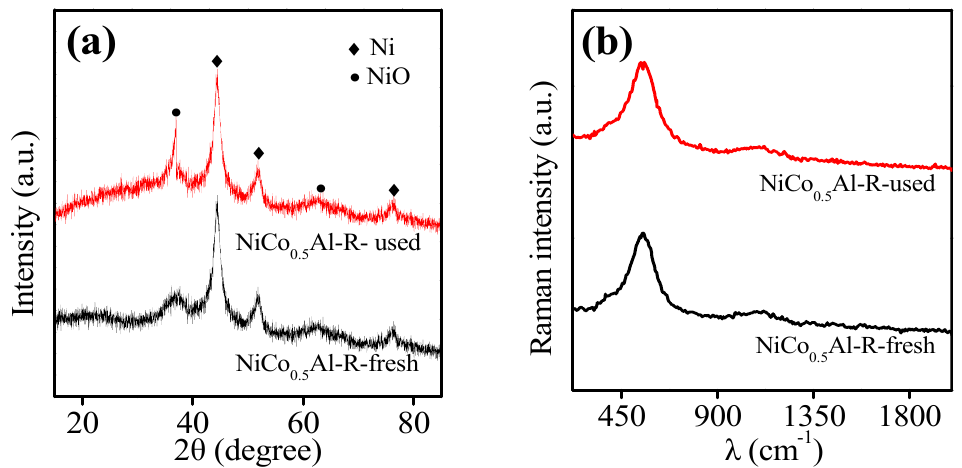
Figure 10. XRD patterns ( a ) and Raman spectrum ( b ) of NiCo 0.5 Al-R-fresh and NiCo 0.5 Al-R-used catalysts.